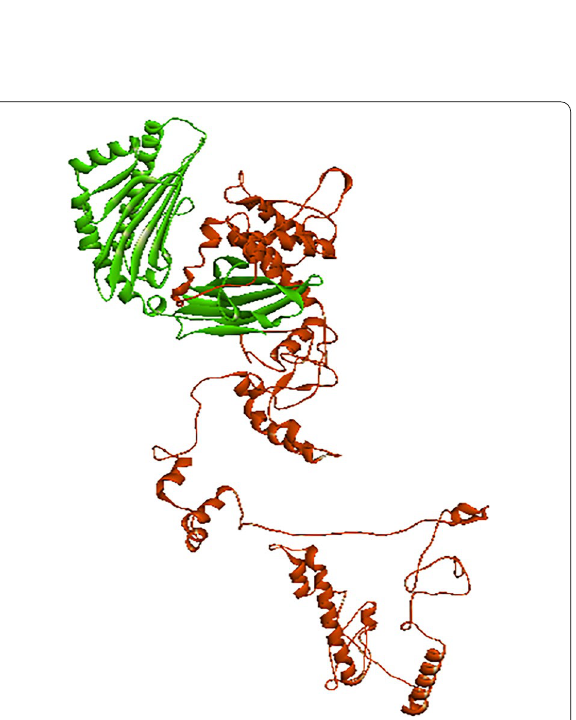
Fig. 6 Docking complex of vaccine structure with A-chain HLA-A02:01 receptor. The receptor is shown in green, and the vaccine structure is shown in